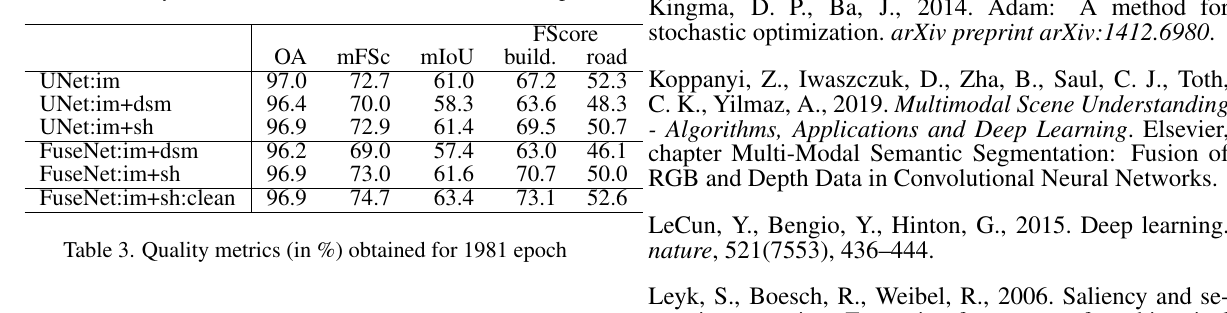
Table 2. Quality metrics (in %) Results obtained for 2001 epoch